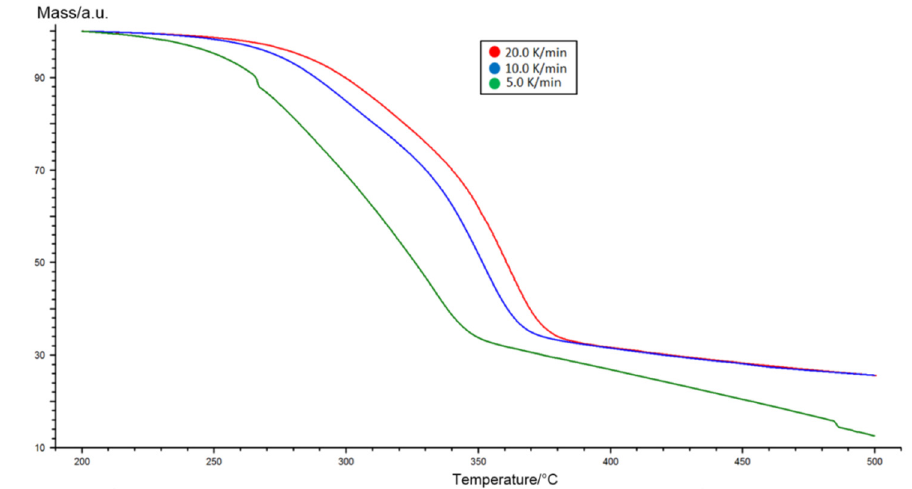
Figure 5. Thermogravimetric analysis results for heating speeds of 5, 10, and 20 K/min determined for Miscanthus.